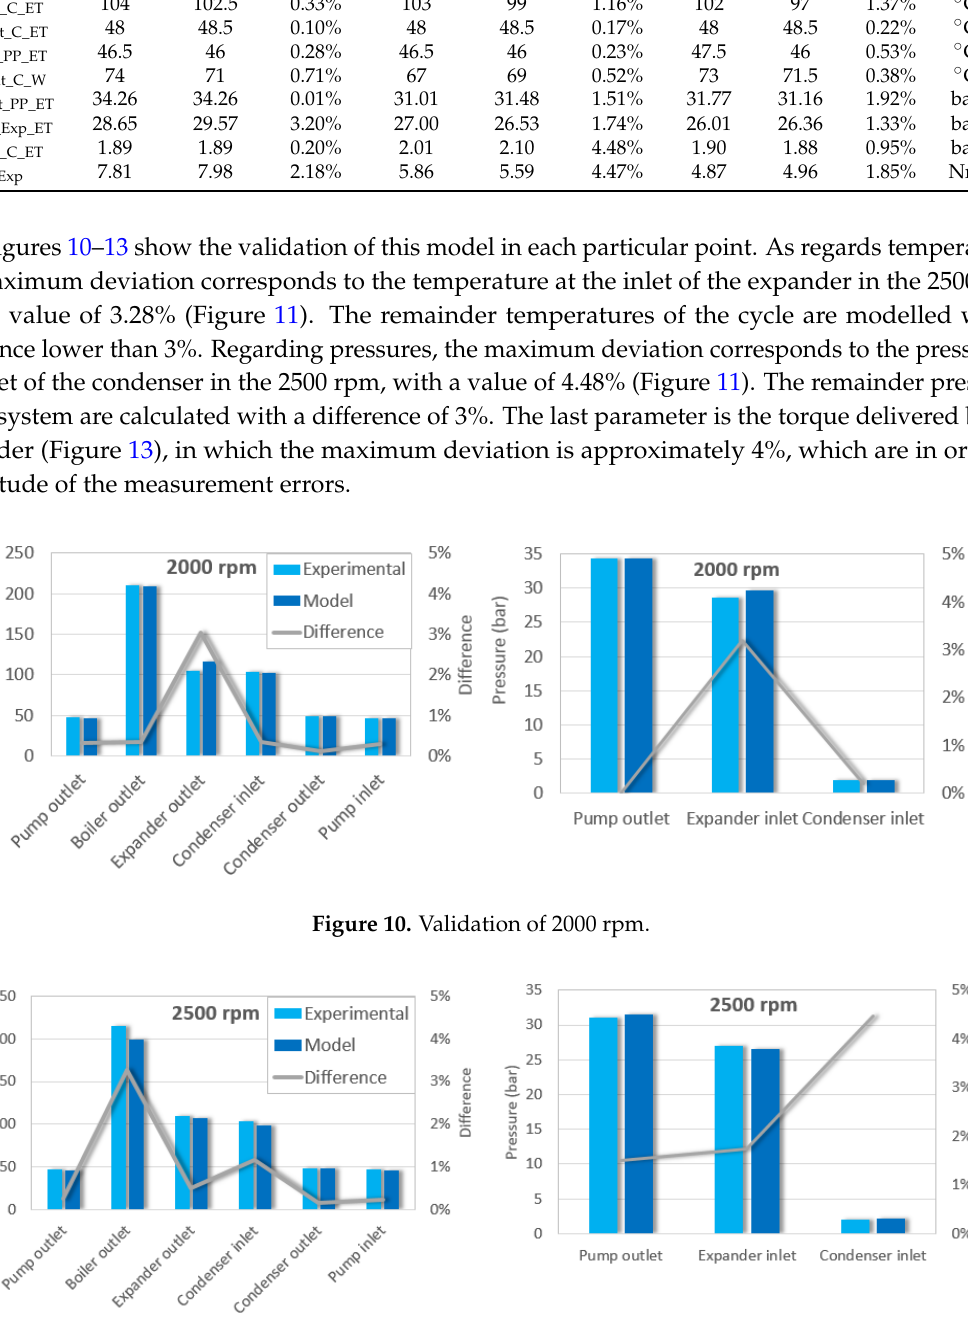
Figure 12. Validation of 3000 rpm. Figure 13. Validation of torque.